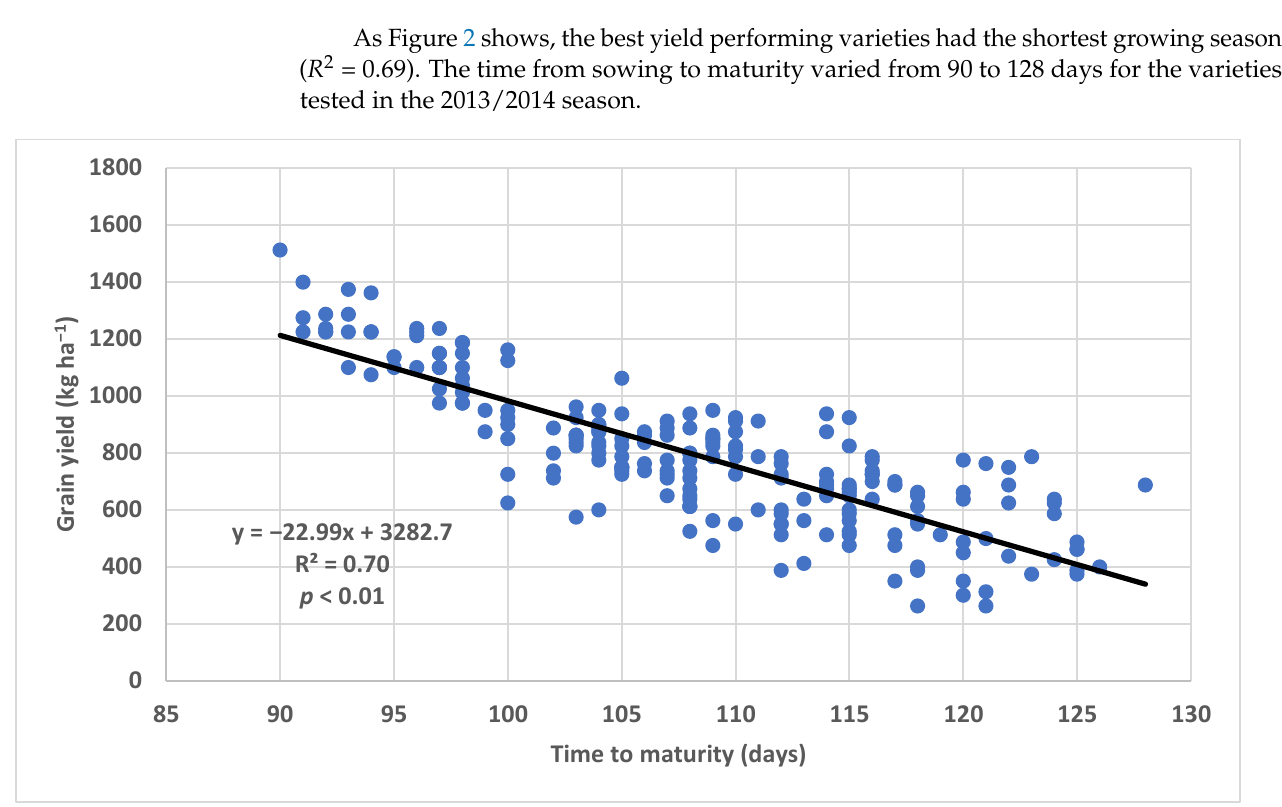
Figure 2. Linear regression of the yields of 54 sorghum varieties and time to maturity (2013/2014 season, Yélimané).